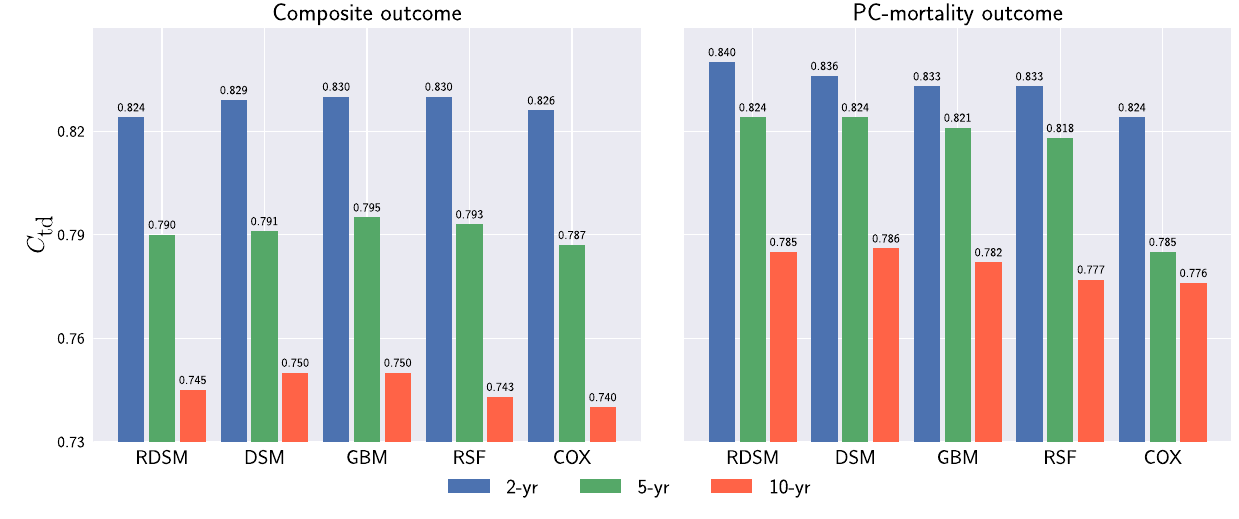
Figure 8. Averaged regional performance of all